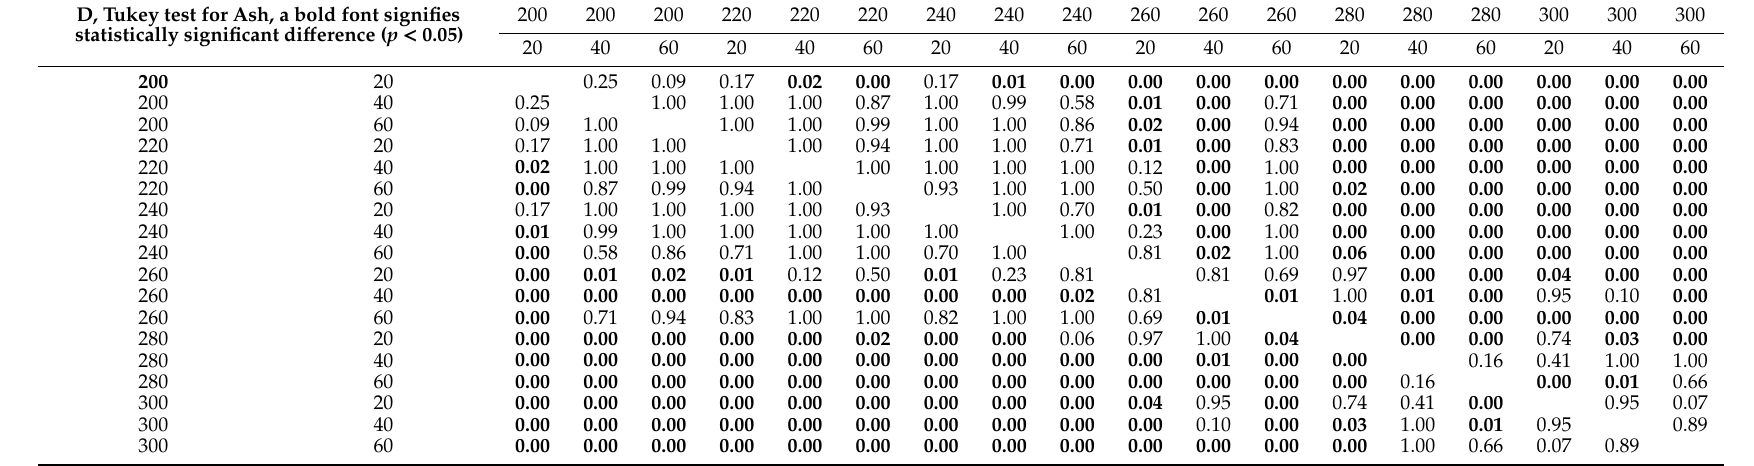
Table A11. Analysis of variance for ash content of